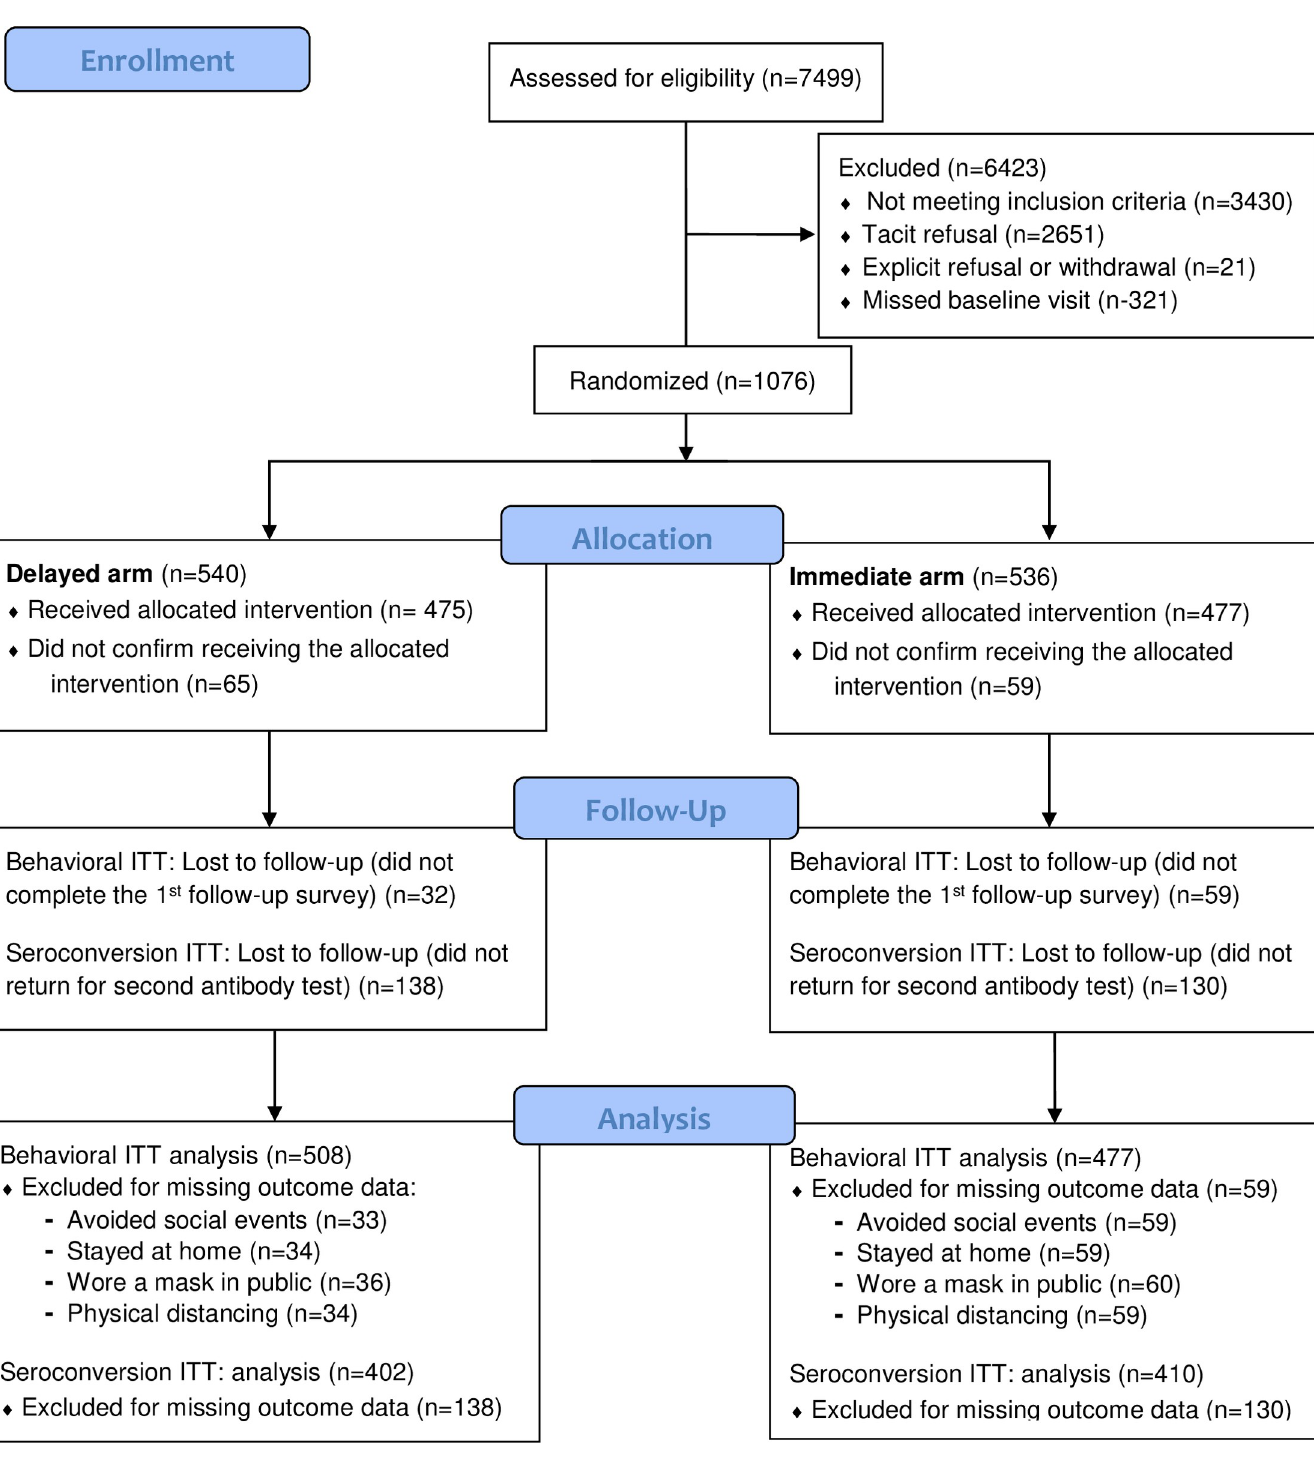
Fig 1. Consort participant flow